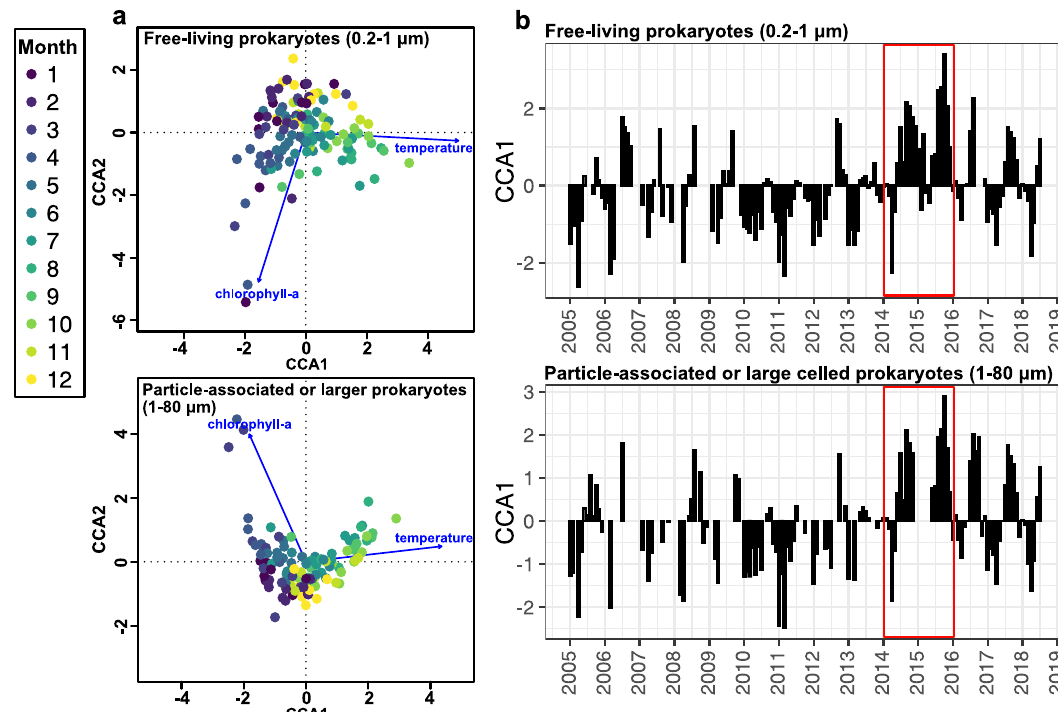
Fig. 3 | Canonical correspondence analysis (CCA) ordination illustrating the seasonal succession of the free-living and particle-associated prokaryotes, respectively. a CCA biplot for free-living (0.2 – 1 μ m) and particle-associated or large-celled (1 – 80 μ m) prokaryotes. The environmental variables analyzed are indicated as vectors, speci fi cally water temperature and monthly average satellite chlorophyll-aconcentration(chlorophyll-a).Theprokaryoticcommunitiesforeach sampling month are represented as circles and color-coded with the sampling months. b Temporal variation of the fi rst CCA scores, which are measures of the